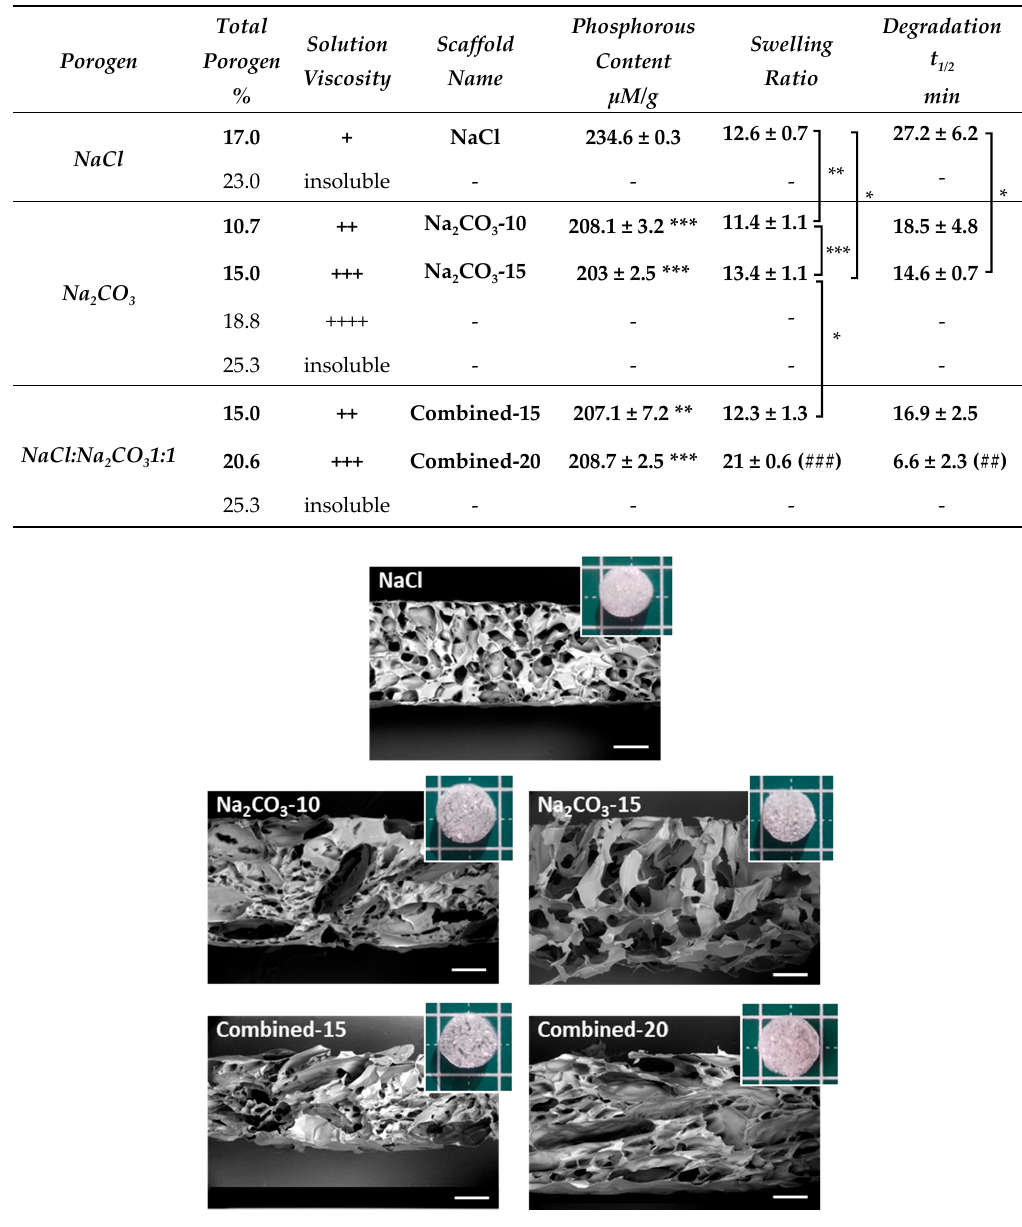
Figure 1. Macroscopic and microscopic (SEM) analysis of scaffold structures in dry state. Scaffolds for vacuum mode (40 Pa) at a 20-kV acceleration voltage. Scale bars on SEM pictures are 500 µ m. Five representative dry sca ff olds placed on a 1 × 1 cm mat are shown in